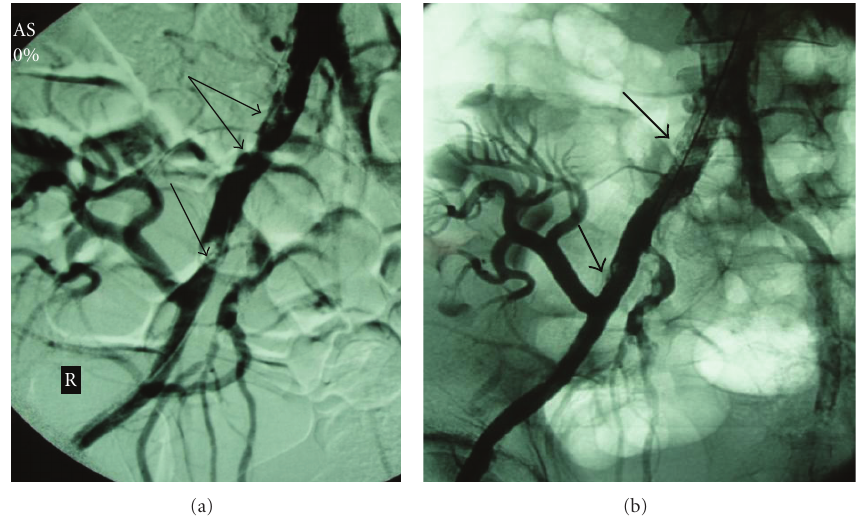
Figure 4: (a) Common and external iliac artery stenosis (arrows) provoking claudication and renal insu ffi ciency. (b) Image following angioplasty and stenting of the common and external iliac artery stenosis